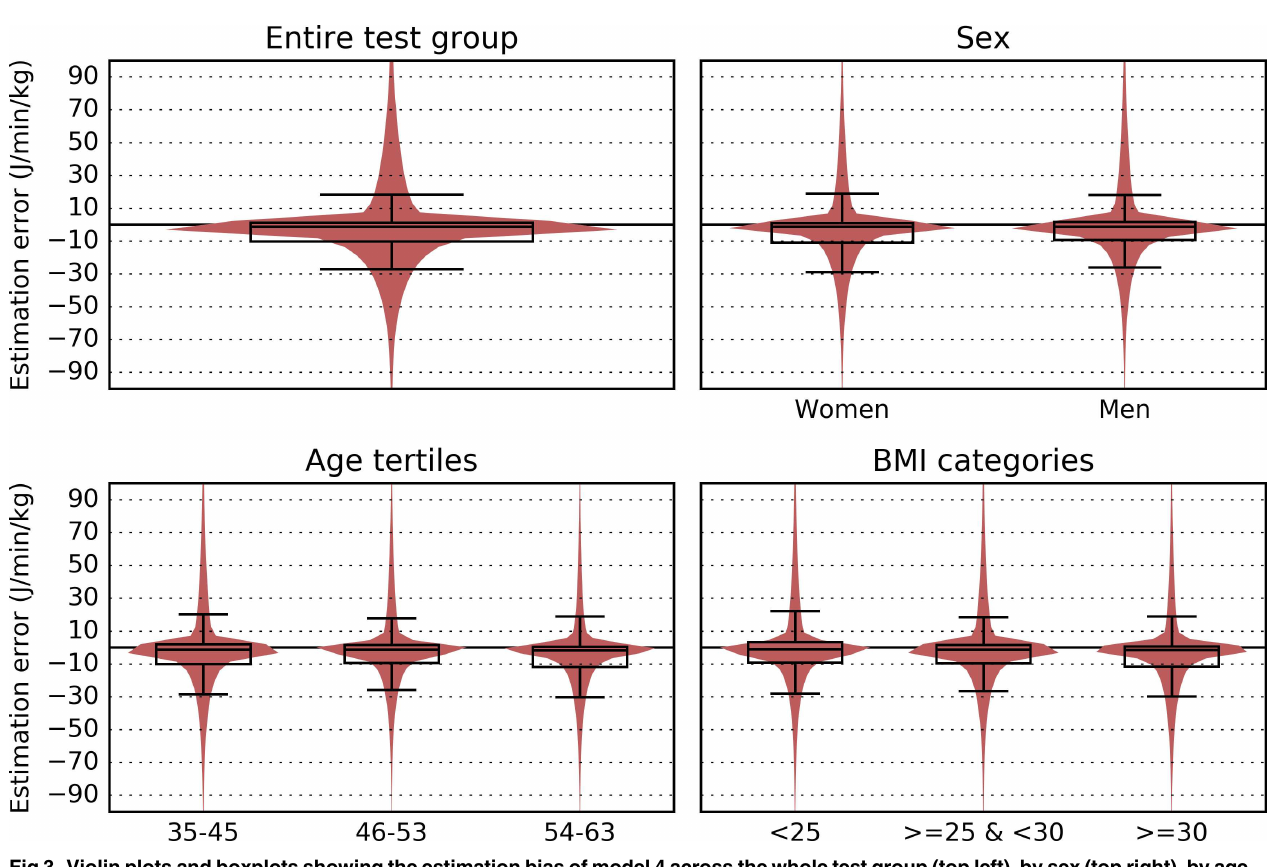
Fig 3. Violin plots and boxplots showing the estimation bias of model 4 across the whole test group (top left), by sex (top right), by age tertiles (bottom left) and BMI categories (bottom